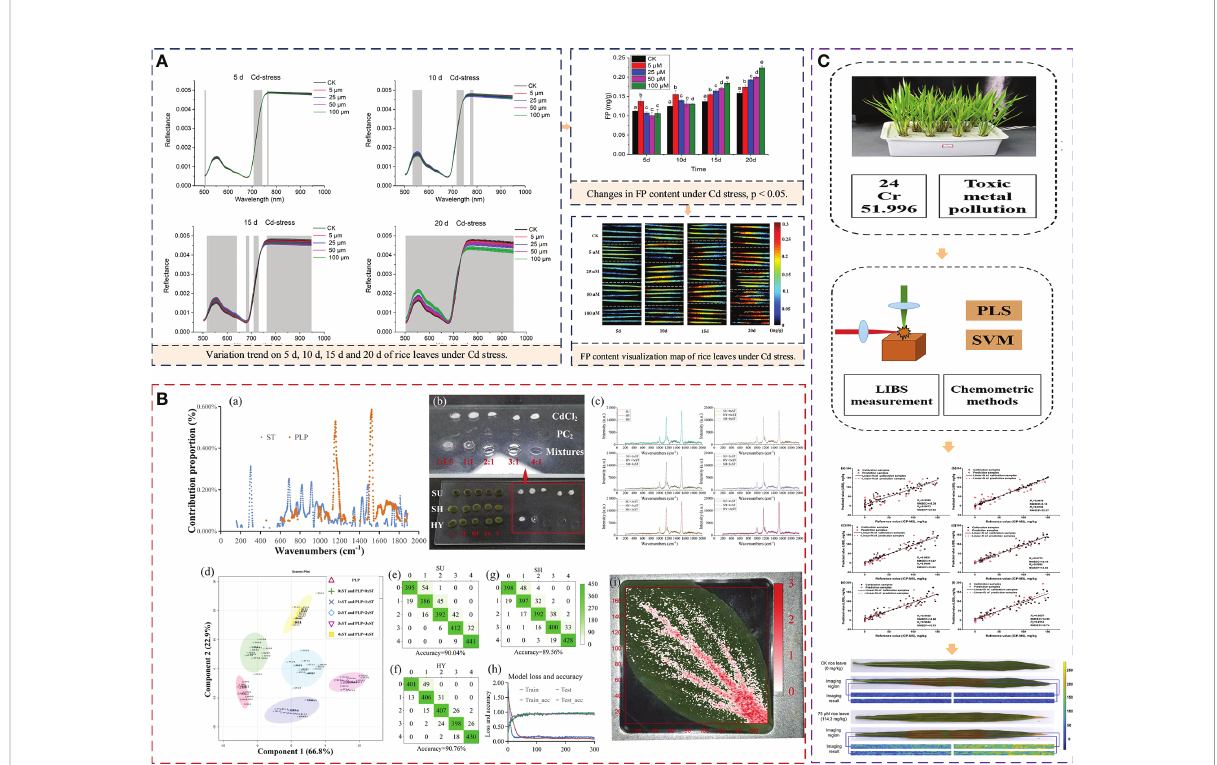
FIGURE 5 Spectrum processing process and fl ow chart. (A) Flowchart of image processing and data analyses for predicting the FP in rice leaves. Different letters (a, b, c, d, e.) in each histogram indicate a signi fi cant difference at P<0.01. (B) Raman spectrum analysis results of leaf tissue of Pakchoi under heavy metal cadmium stress. (C) Optimization method for rapid visualization of chromium distribution in rice leaves by LIBS spectroscopy. FP, free proline; ST, standard; PLP, pure leaf powders; PLS, partial least squares; SVM, support vector machine; LIBS, Laser- induced breakdown